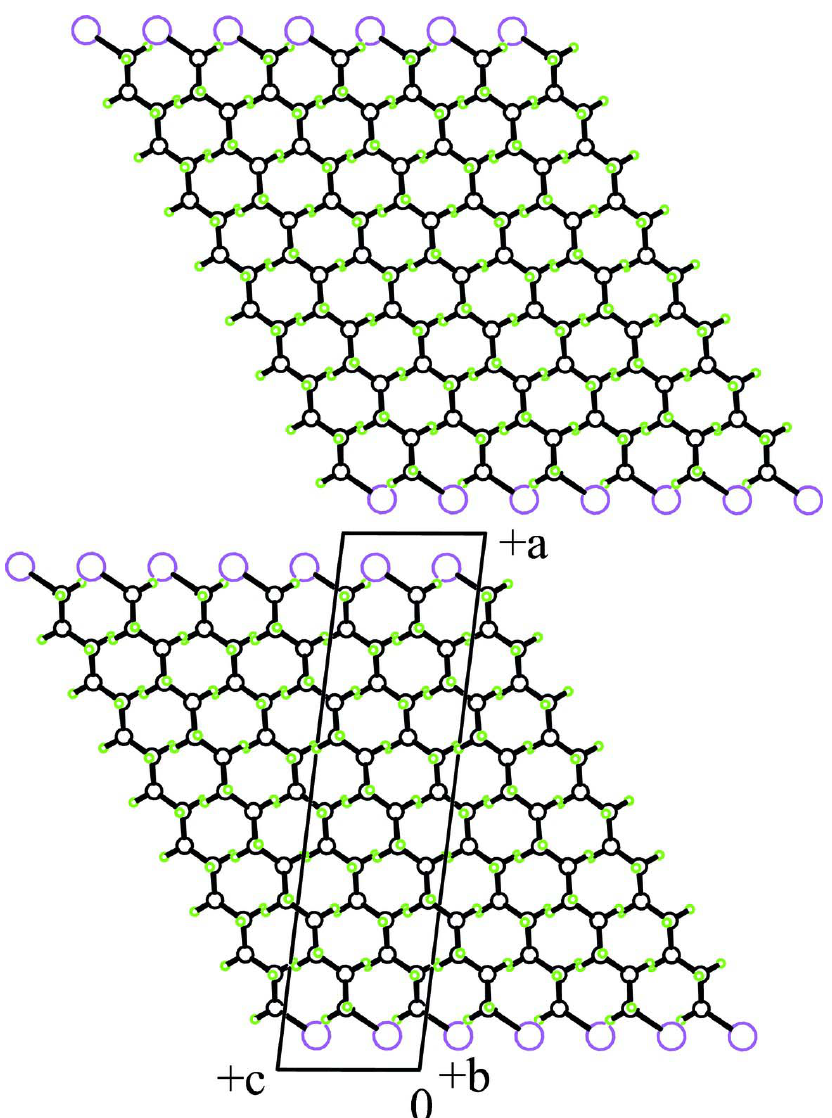
Figure 2 The projection of the crystal structure of (I) along the b